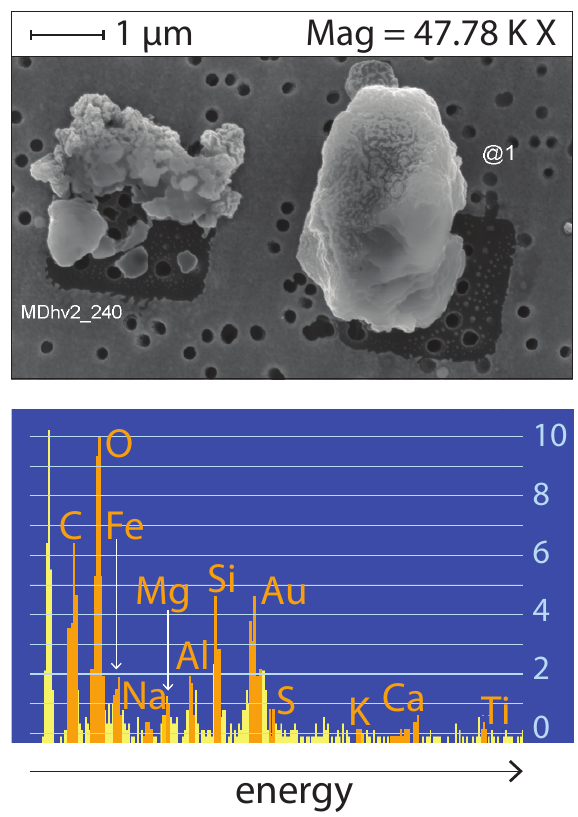
Fig. 3. SEM and EDX analysis of a mineral dust grain (right-hand grain) following a NanoSIMS measurement. The dark squares on the filter in the SEM image show where the NanoSIMS analysis has sputtered away the gold-coating. In the SEM EDX spectrum, element windows are highlighted in orange while the background is shown in